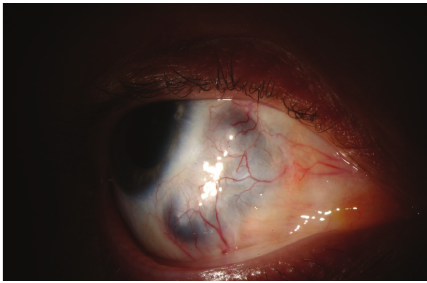
Figure 2: Slit lamp photograph of patient’s right eye two months after initial presentation showing scleromalacia over initial locus of